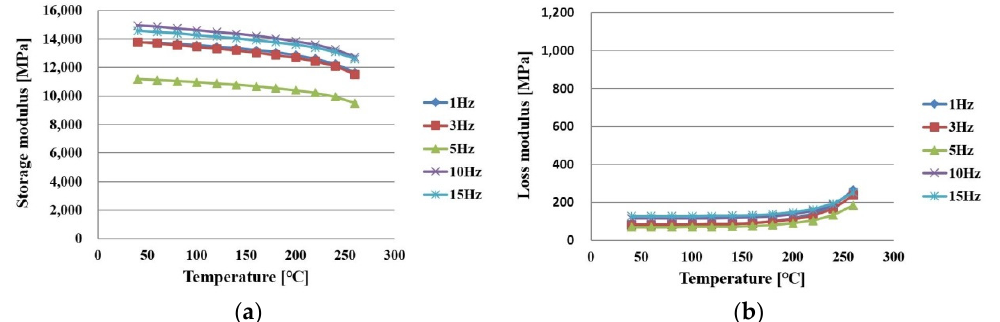
Figure 10. Measurement results of PPG in a y direction after being cured as a function of frequency: ( a ) storage modulus; ( b ) loss modulus.